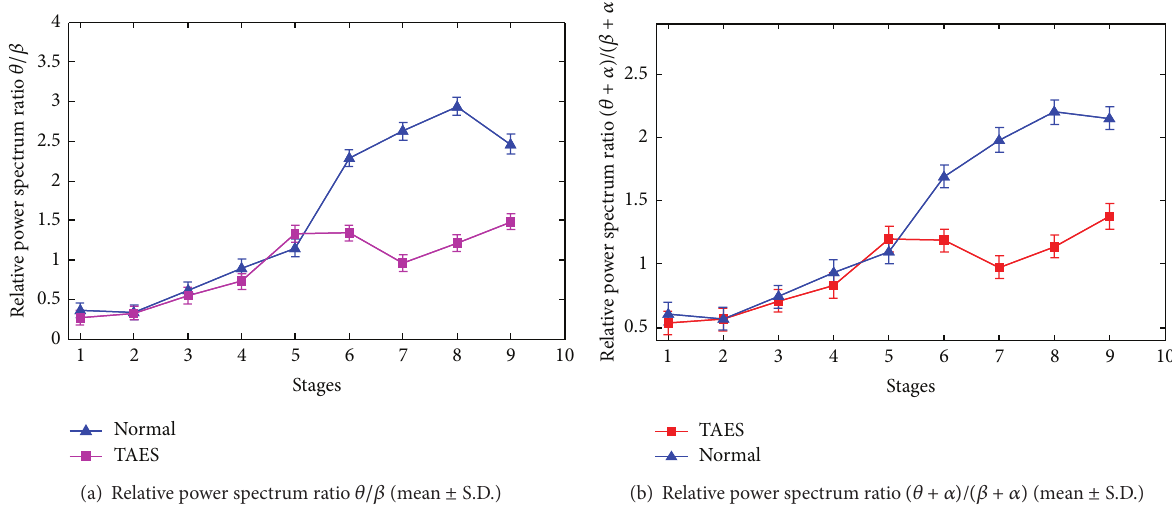
Figure 8: Ratios 𝜃/𝛽 and (𝜃 + 𝛼) / (𝛽 + 𝛼) of the relative power spectrum for 9 stages of